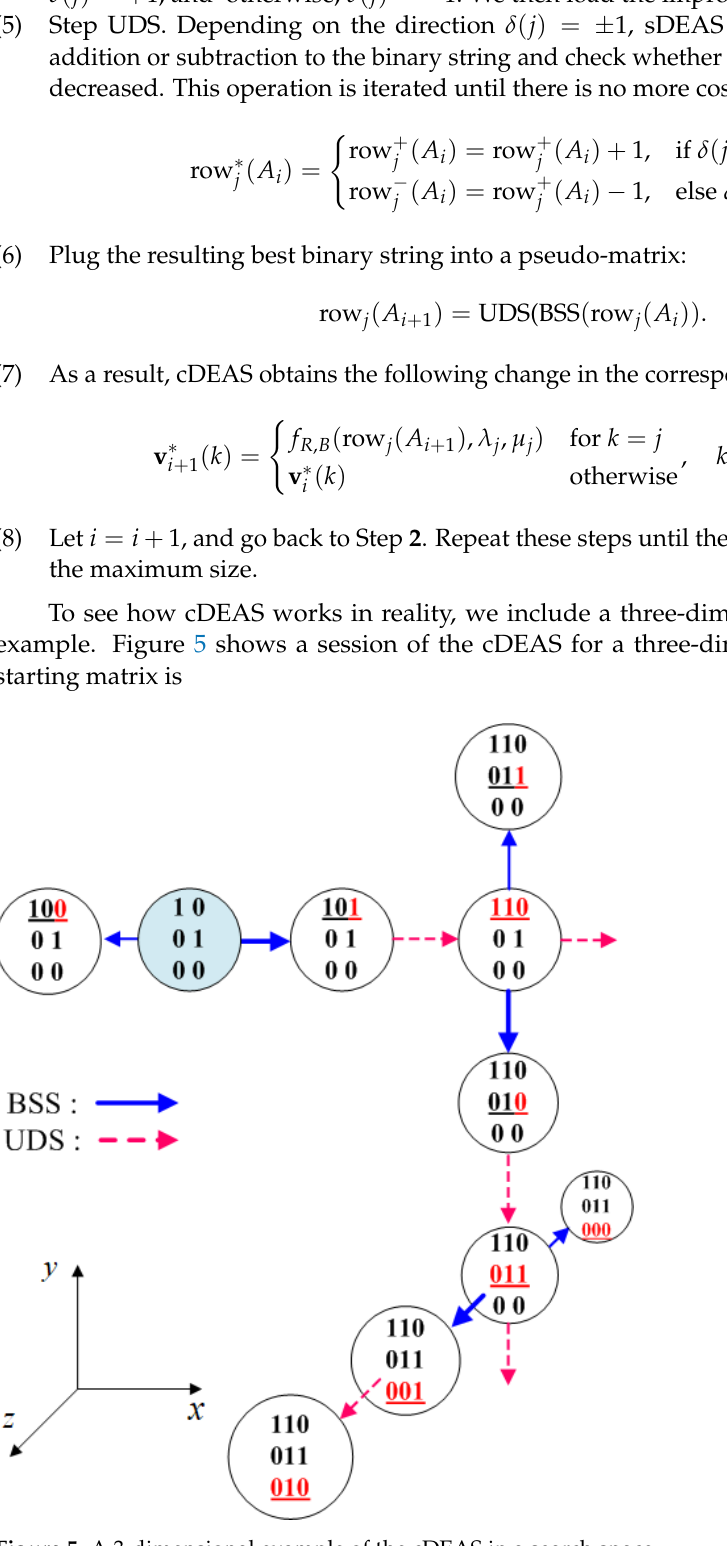
Figure 5. A 3-dimensional example of the cDEAS in a search